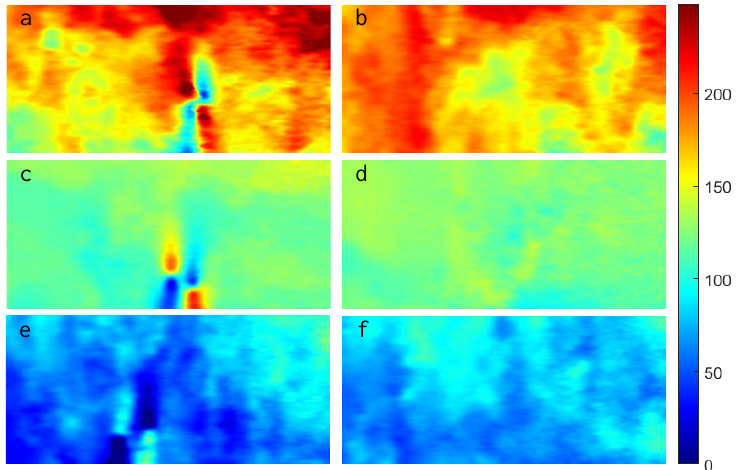
Figure 5. Wind field images with and without a wake. ( a ) Positive downwind; ( b ) negative down- wind; ( c ) positive calm wind; ( d ) negative calm wind; ( e ) positive headwind; ( f ) negative headwind.